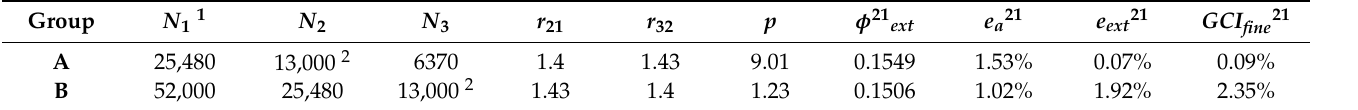
Table A2. Sample uncertainty analysis by different spatial resolution.